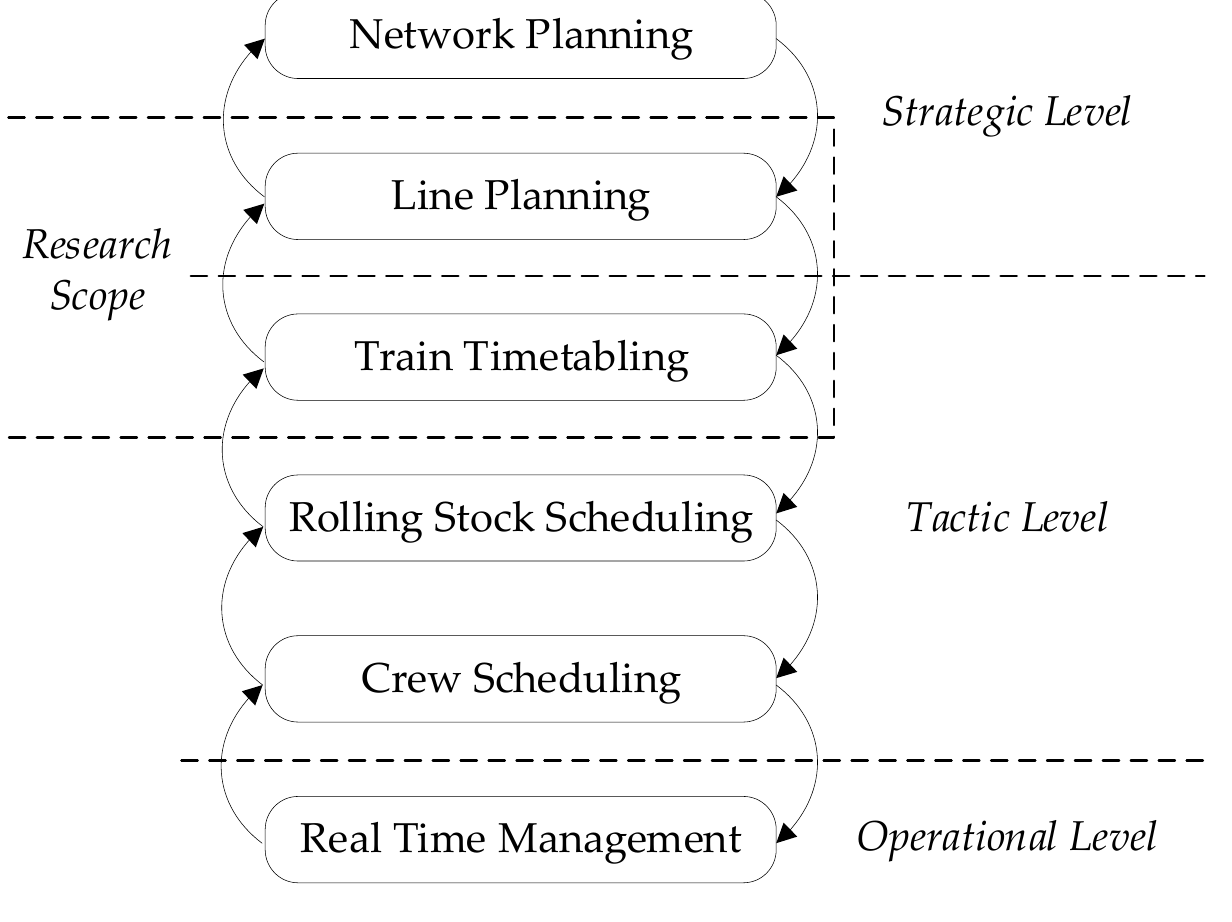
Figure 1. Railway planning process.